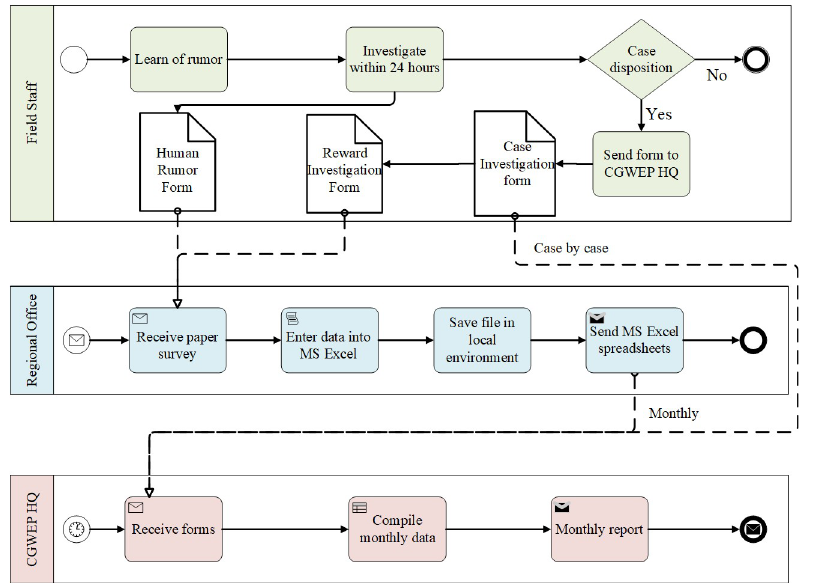
Fig 3. Information workflow of rumor and infection investigations in humans.